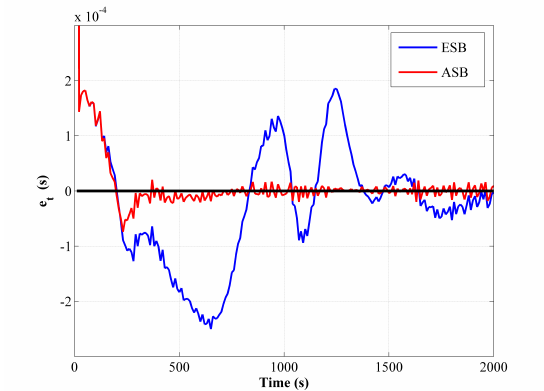
Figure 7. Comparison of transit time measurement innovation between the ESB and the ASB algorithms using simulation data with unknown Q k